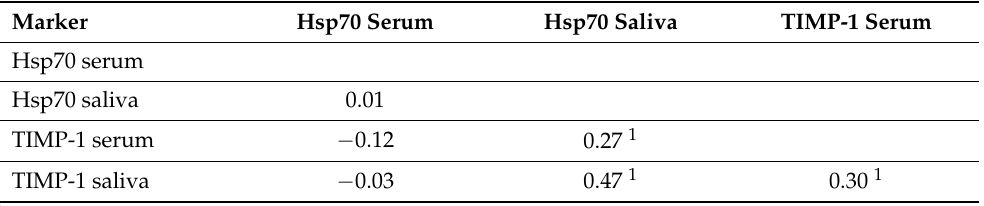
Table 2. Spearman correlation (rho) of the markers in saliva and serum (samples of pretreatment HNSCC patients ( n = 53) and control subjects ( n = 40). Marker Hsp70 Serum Hsp70 Saliva TIMP-1 Serum Hsp70 serum Hsp70 saliva 0.01 TIMP-1 serum − 0.12 0.27 1 TIMP-1 saliva − 0.03 0.47 1 0.30